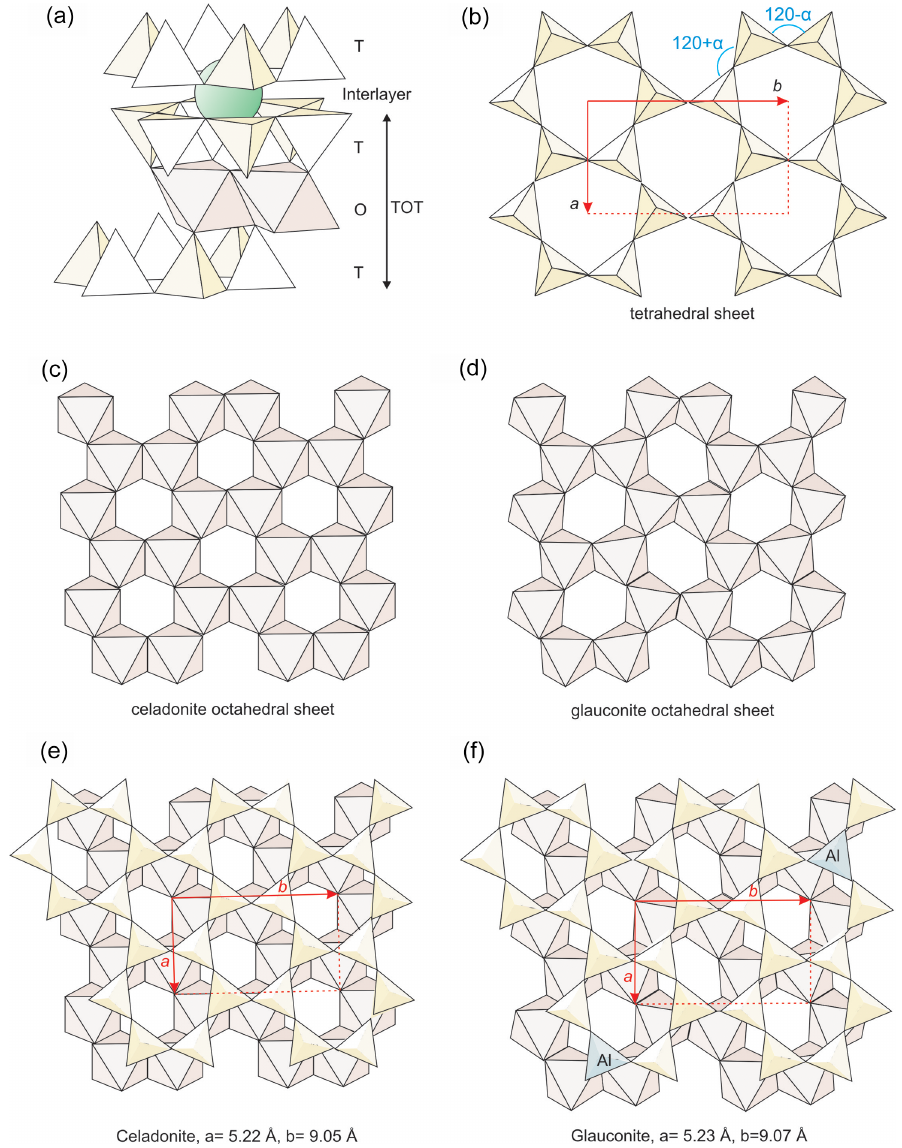
Figure 10. Structural details of micas to show the differences between celadonite and glauconite: (a) general structure of micas; (b) geom- etry of the tetrahedral sheet with the ditrigonal distortion angle ( α ) indicated; (c, d) octahedral sheets respectively of celadonite and other dioctahedral phyllosilicates; (e, f) matching between tetrahedral and octahedral sheets of the two kinds of micas, with the difference of lattice parameters